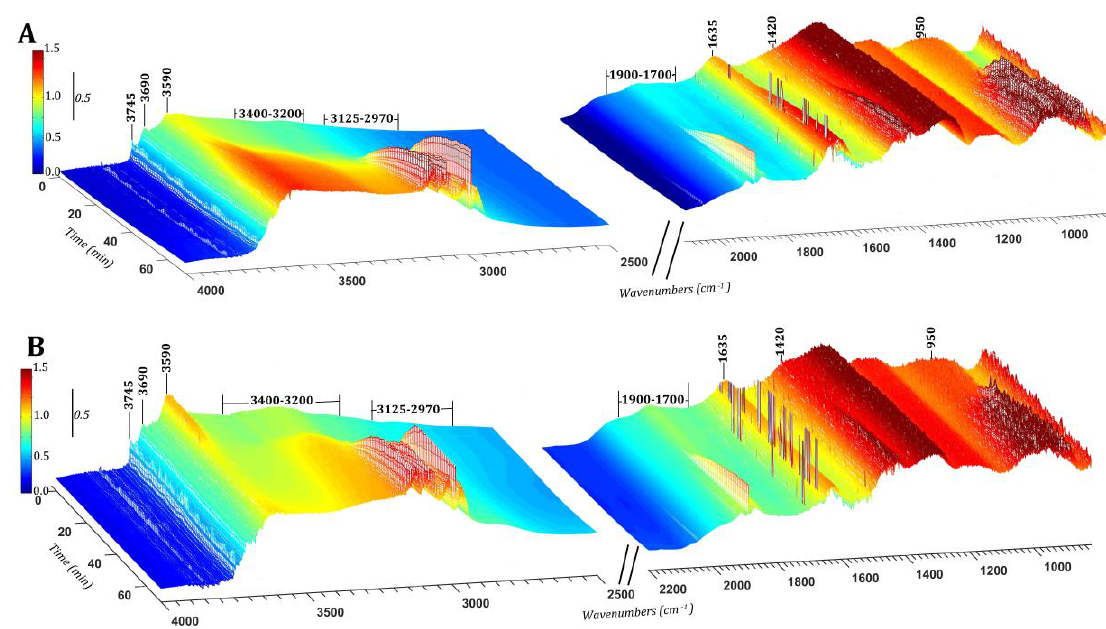
Figure 4. DRIFTS operando spectra of ethylene adsorption onto natural and modified natural zeolite samples in the presence of humidity. ( A ) Natural zeolite; ( B ) zeolite modified with copper and zinc.